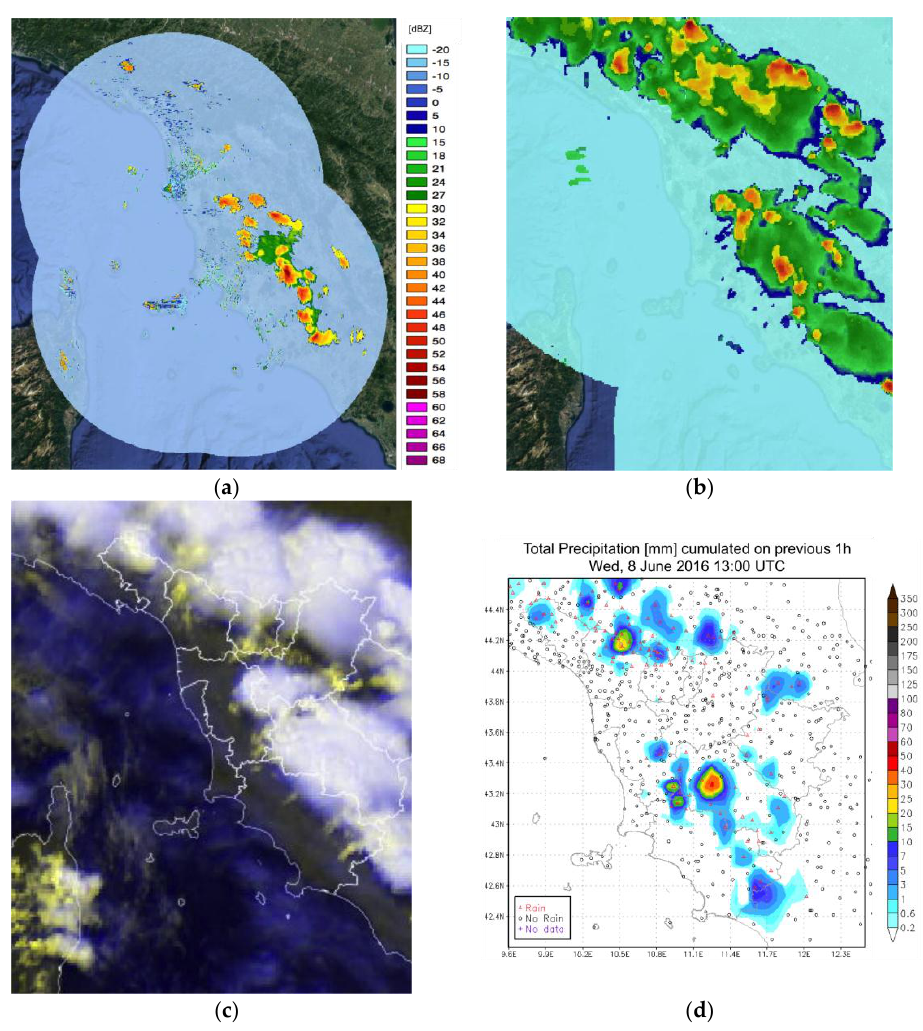
Figure 8. For the case study of 8 June 2016: ( a ) Mosaic of VMI reflectivity for the regional X-band radar network (12:45 UTC); ( b ) Mosaic of VMI reflectivity for the Italian National weather radar network (12:50 UTC); ( c ) MSG HRV channel (12:45 UTC); ( d ) 1-h (12:00–13:00 UTC) cumulated precipitation obtained from measurements of the regional rain gauge network.